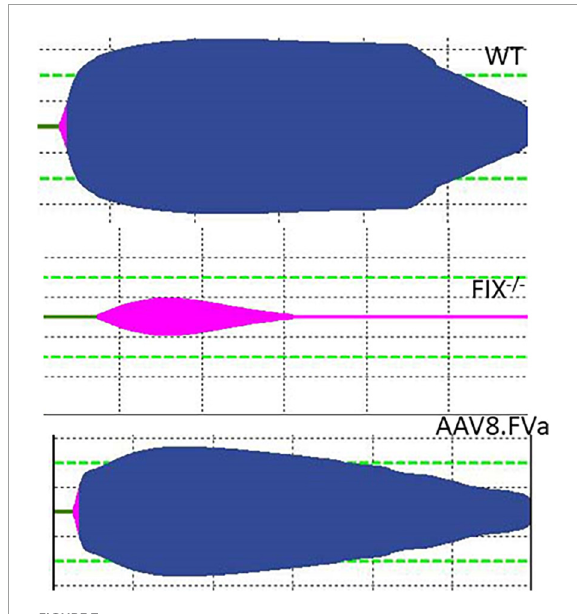
FIGURE7 Evaluate the risk of thrombosis after AAV8/hFVa treatment by fibrinolysis on ROTEM. Fibrinolysis analysis using whole blood collected from the inferior vena cava at the end of experiments was performed on ROTEM for mice ( Figure 6